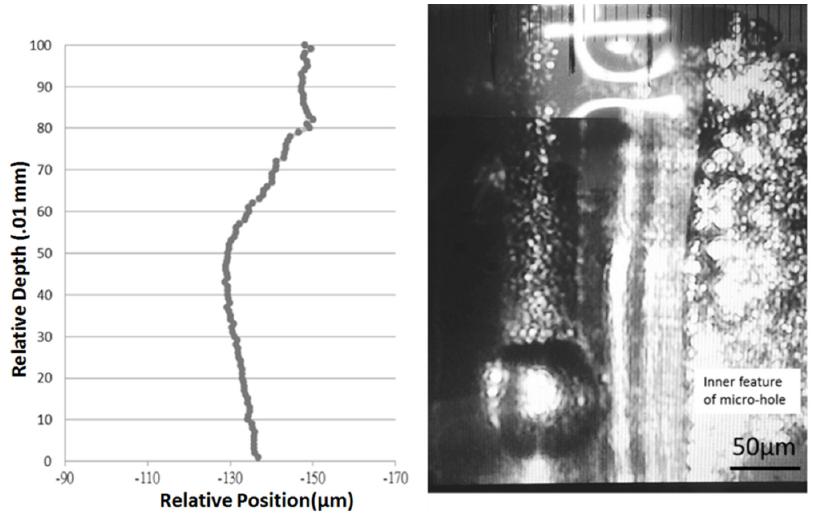
Figure 12. Consistency of measuring the inner profile of a micro ‐ hole: the proposed vs. optical device.